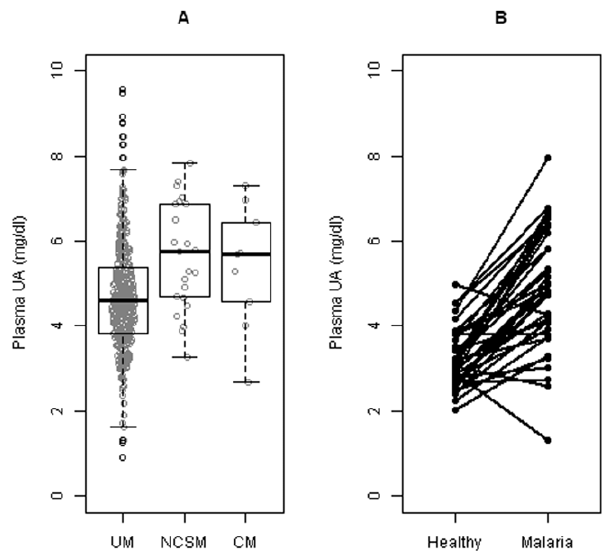
Figure 1. Uric acid (UA) elevations in Malian children with uncomplicated and severe falciparum malaria. a, Plasma UA levels were measured in Malian children who presented with uncomplicated (UM), non-cerebral severe (NCSM) and cerebral malaria (CM). We show traditional boxplots (i.e., middle line is median, box is interquartile range) with points randomly jittered according to their density similar to violin plots [36][37]. b, Plasma UA levels were measured in a cohort of 39 healthy aparasitemic Malian children in May 2008 (prior to the malaria season) and again at their first episode of UM during the 2008 malaria